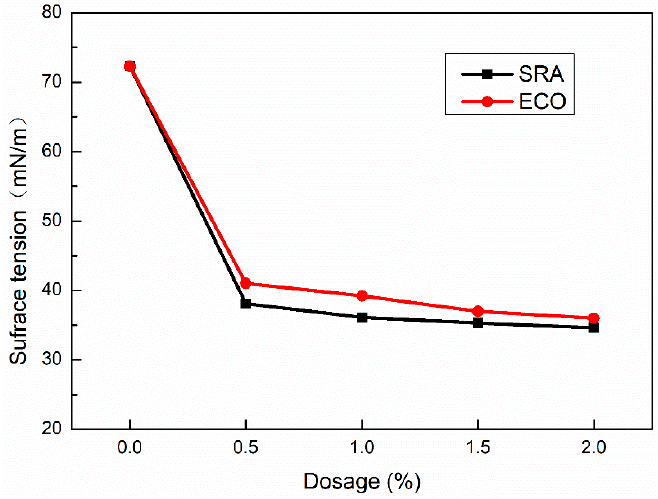
Figure 10. Surface tension of solution with various dosage of ECO.